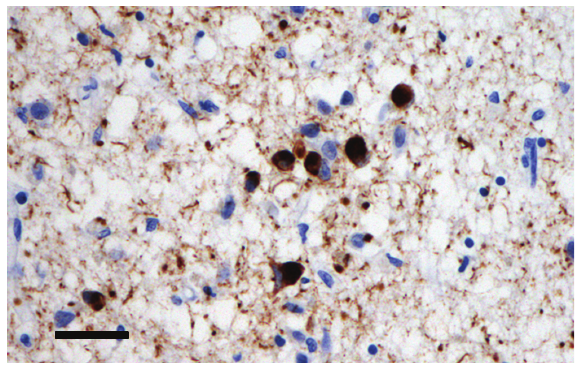
Figure 2: Cells from the cerebral cortex showing the presence of Lewy bodies ( α -synuclein immunohistochemistry, haematoxylin stain, bar = 25 μ m).